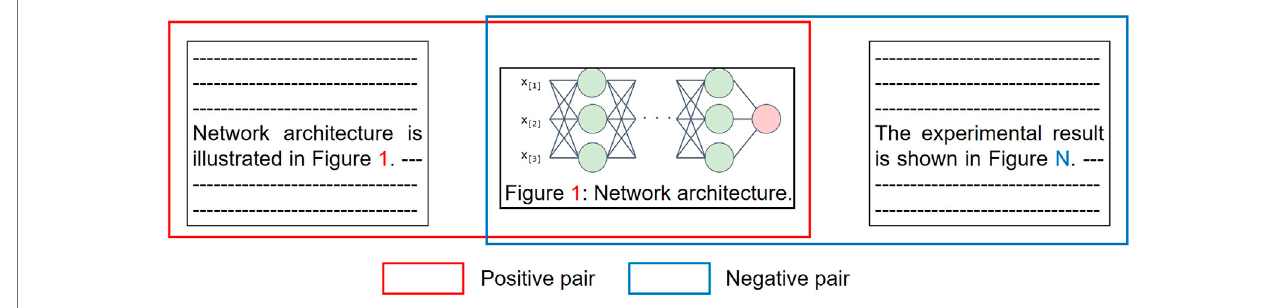
FIGURE 4 | Creation of paragraph- fi gure pairs used as training instances for our models. For a single training instance, positive and negative pairs are created. A fi gure is paired with paragraphs which refers to the fi gure and different one in positive and negative pairs, respectively.